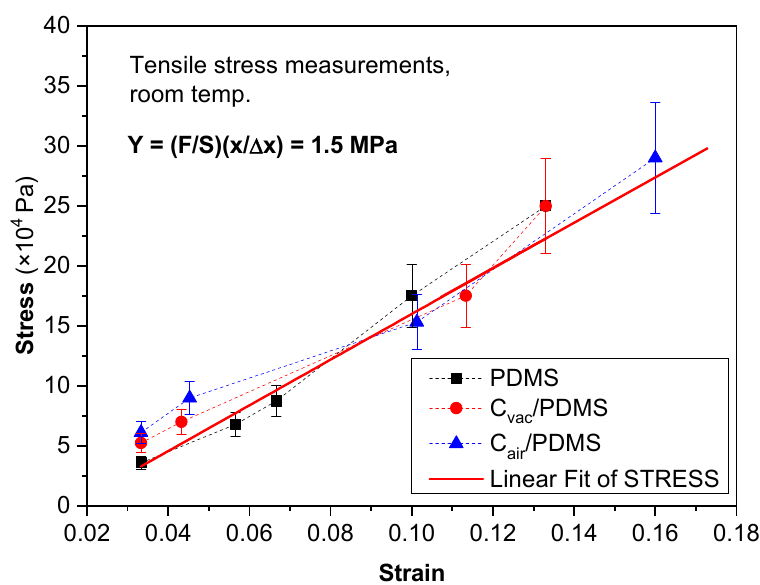
Figure 10. Stress-strain curves for the virgin PDMS (full black squares), PDMS with HOPG de- posited in vacuum by PLD (full red circles) and PDMS with HOPG deposited in air by LIBT (full blue triangles).